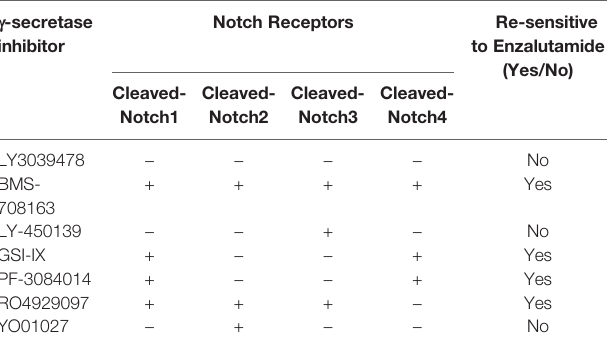
TABLE 3 | The effectiveness of g -secretase inhibitors on reversing enzalutamide resistance by inhibiting activities of Notch receptors. g -secretase